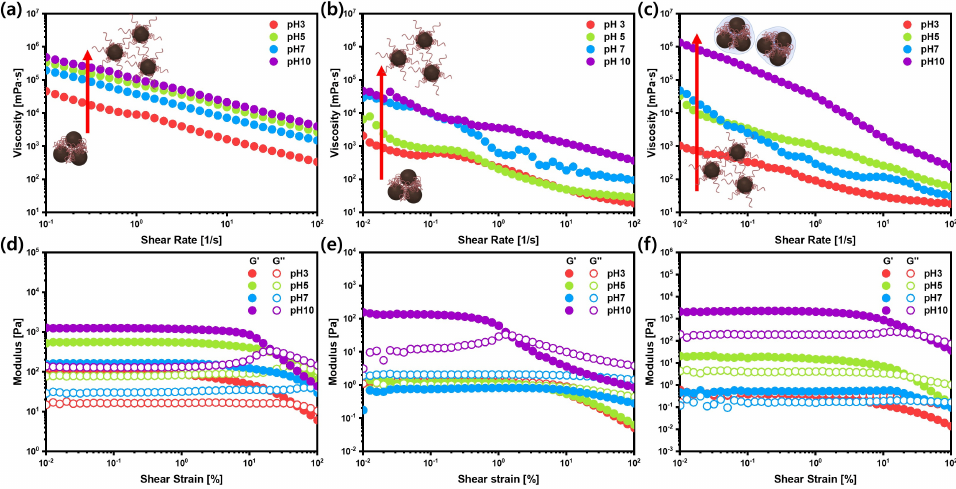
Figure 3. ( a – c ) Steady shear viscosity, ( d – f ) storage moduli ( G (cid:48) ), and loss moduli ( G (cid:48)(cid:48) ) of silicon anode slurries under various pH conditions with different binders. ( a , d ) PAA binder, ( b , e ) CMC/SBR binder, and ( c , f ) chitosan